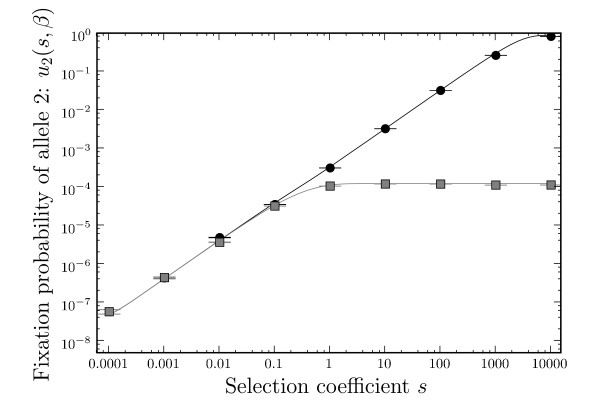
Fixation probability of allele 2 (u2) vs. the selection coefficient s. Black is for u2(s, β), grey is for u2(s, 0). Solid lines are predictions according to Eq. (2) and (3), data points are for simulations with 109 repeats. N = 104, U=81910−8, β = 0.00019, T = 5 × 105. Error bars are standard errors.